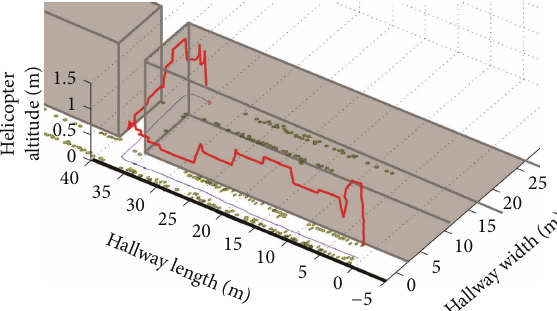
Figure 16: Cartesian (𝑥, 𝑦,𝑧) position of the MAV in a hallway as reported by proposed ranging and SLAM algorithm with time- varying altitude. The altitude is represented by the 𝑧 -axis and it is initially at 25cm as this is the ground clearance of the ultrasonic altimeter when the aircraft has landed. MAV altitude was intentionally varied by large amounts to demonstrate the robustness of our method to the climb and descent of the aircraft, whereas in a typical mission natural altitude changes are in the range of a few centimeters.